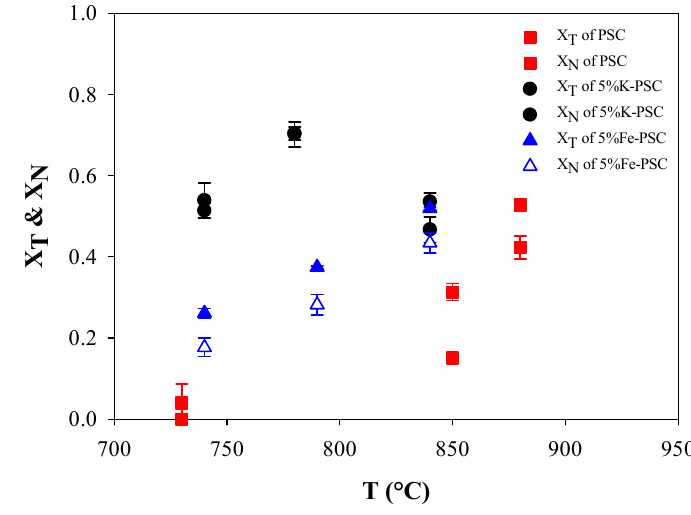
Figure 8. X T and X N from tar reforming over PSC, 5%K-PSC, and 5%Fe-PSC at different temperatures.